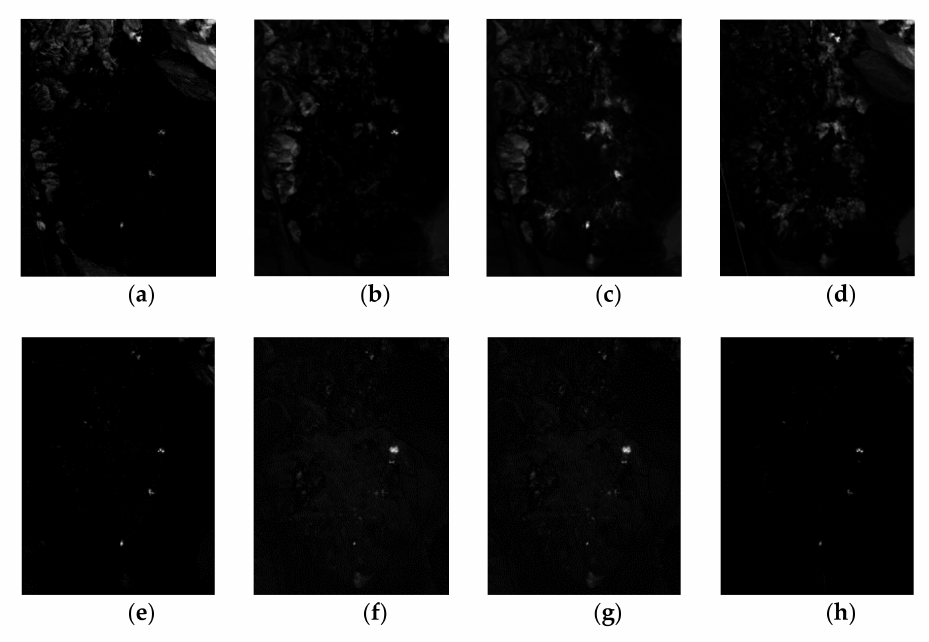
Figure 21. RMSE images: ( a ) VCA, ( b ) N-FINDR, ( c ) SGA, ( d ) C-NMF, ( e ) MVC-NMF, ( f ) ICE, ( g ) SPICE, ( h ) SPEEVD.